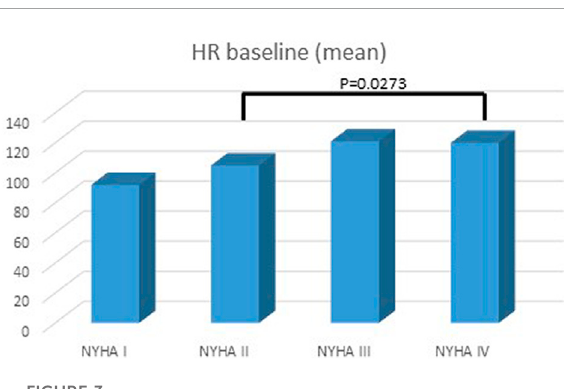
FIGURE 3 Heart rate and NYHA/Ross class at baseline. Highest heart rate was in the IV NYHA/Ross